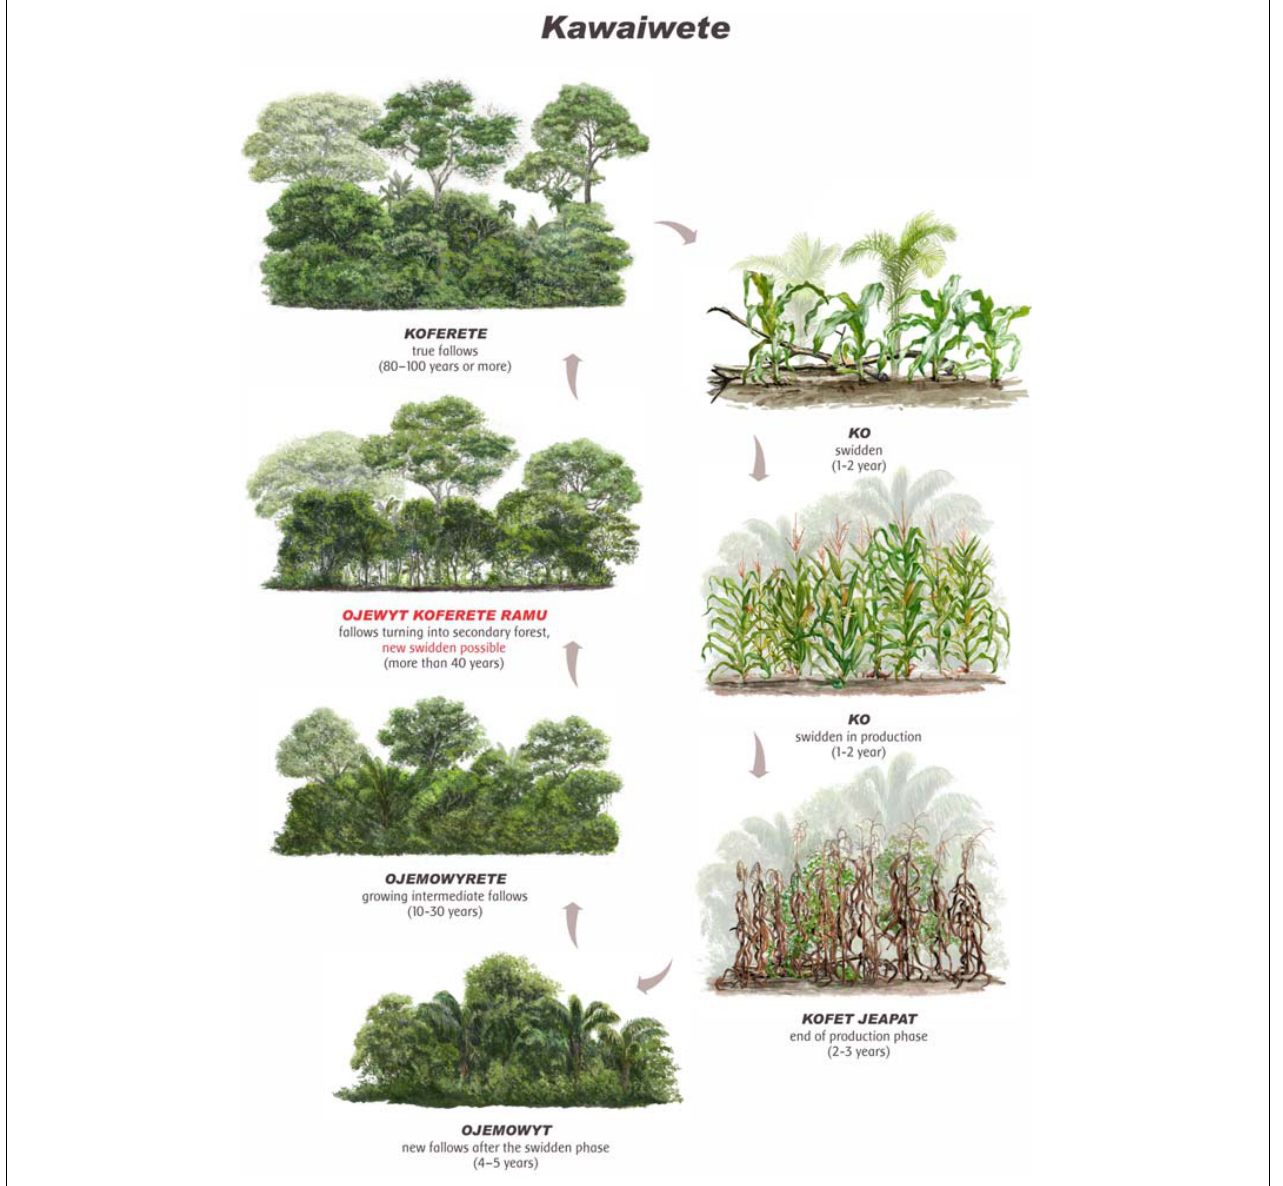
FIGURE 2 | Illustration of Kawaiwete maize ( Zea mays L.) shifting cultivation cycle in anthropogenic soils (ADE). When the fallow reaches the OJEWYT KOFERETE RAMU phase (in red), soils and vegetation are considered as recovered and a new cycle may start ( Ilustração de Gustavo Marigo ).